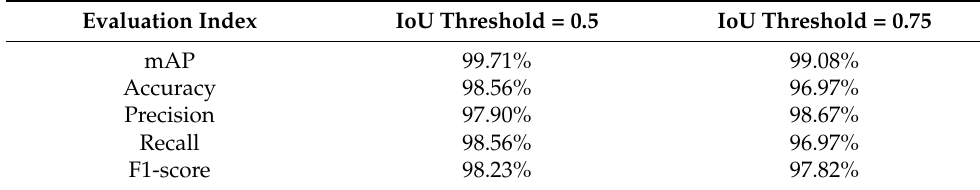
Figure 8. When the IoU threshold was 0.75, the performance comparison of different iterations. Table 12. Performance of Yolov4.